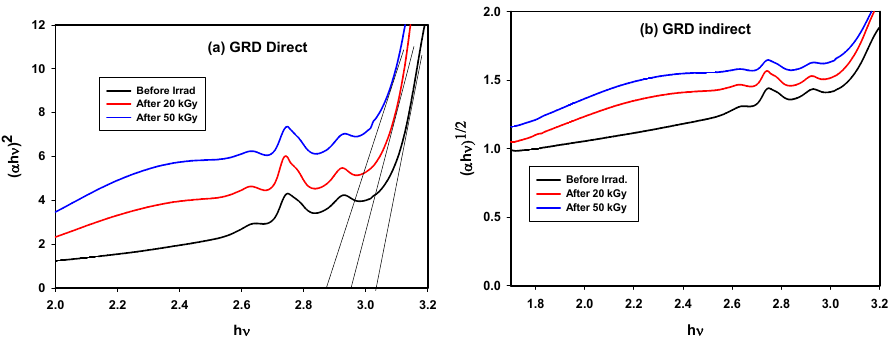
Figure 7. Tauc plot of GRD samples before and after gamma irradiation doses for ( a ) direct and ( b ) indirect energy gap.